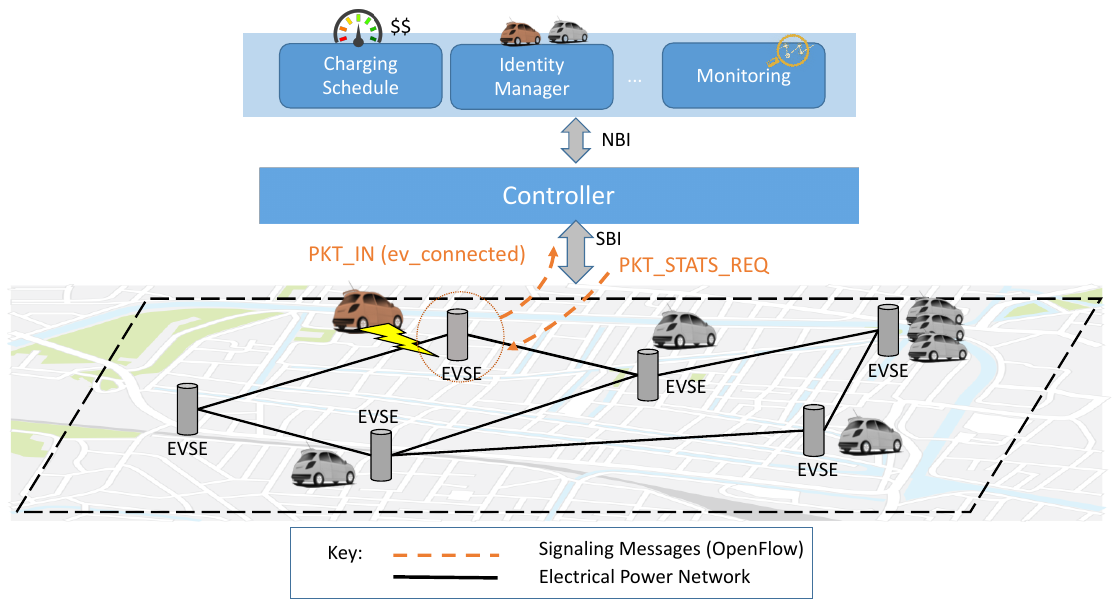
Figure 2. Generic architecture of an SDN-enabled